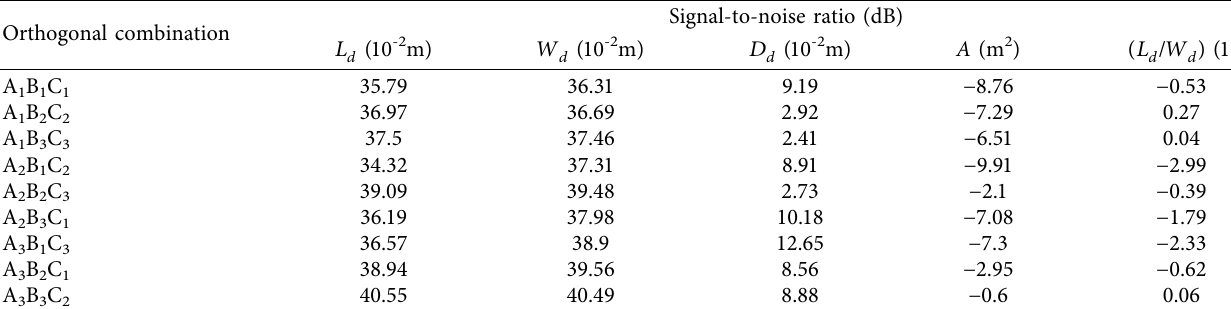
Table 3: The signal-to-noise ratio of elements of deposits